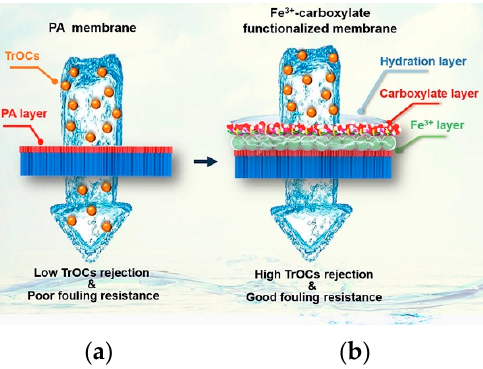
Figure 30. Performance representation of ( a ) unmodified PA ( b ) carboxylate-functionalized PA membranes in FO for removal of TrOCs [308]. Reproduced with permission from Dong, X.; Meng, Q.-W.; Hu, W.; Chen, R.; Ge, Q, Chemical Engineering Journal; published by Elsevier B.V., 2021.